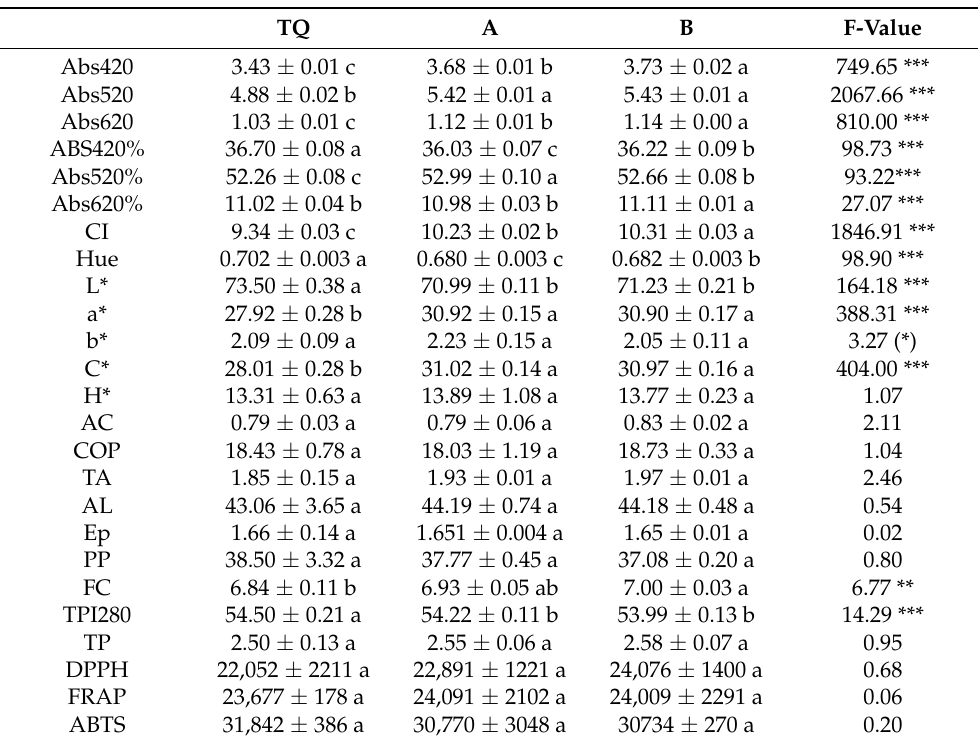
Table 1. Chemical parameters of the wine samples at the start (T0) after the addition of different stabilizing